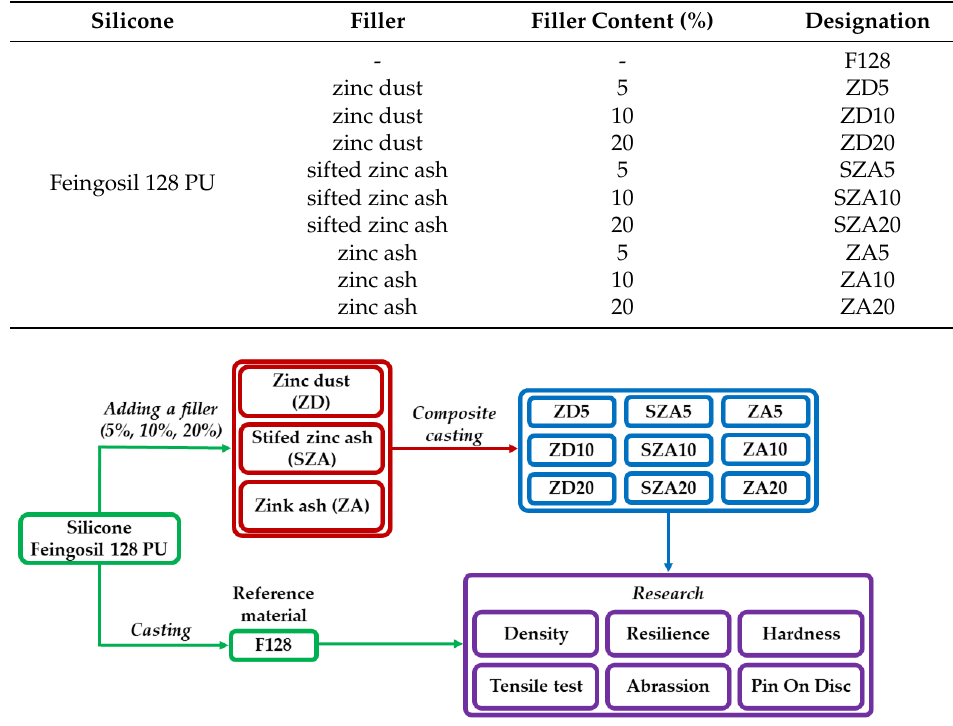
Figure 1. Scheme of the research methodology.